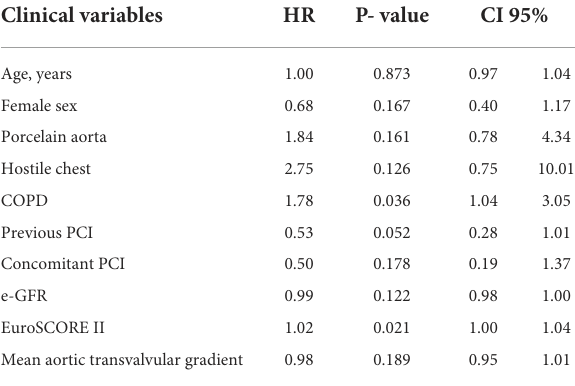
TABLE 3 Independent predictors of 1-year mortality in LFLG AS treated with new-generation THV.